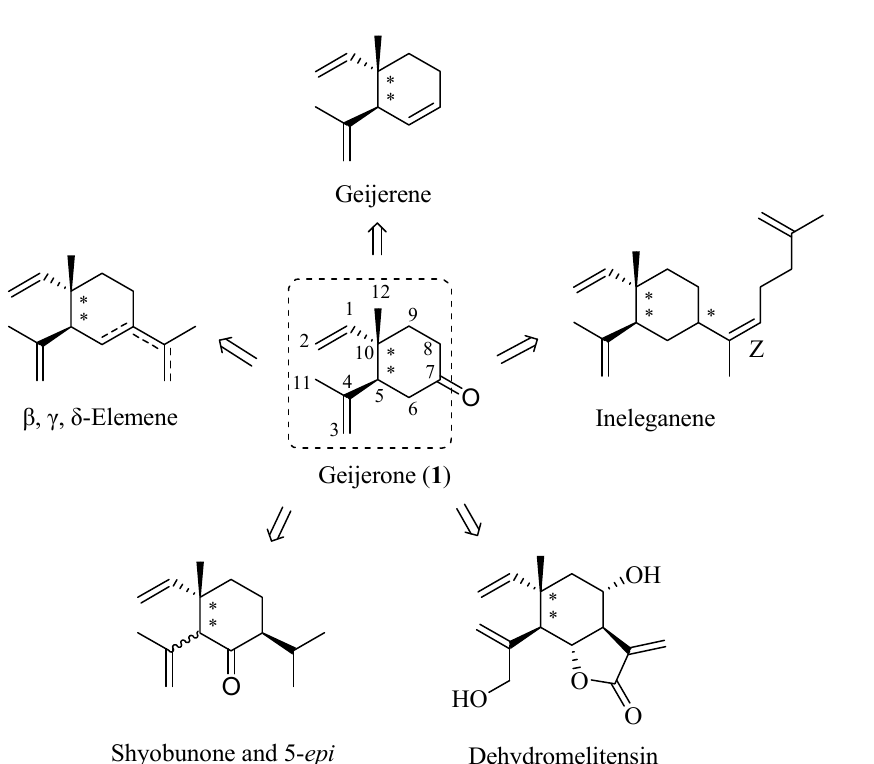
Figure 1. Structures of elemene-type terpenoids and (±)-geijerone ( 1